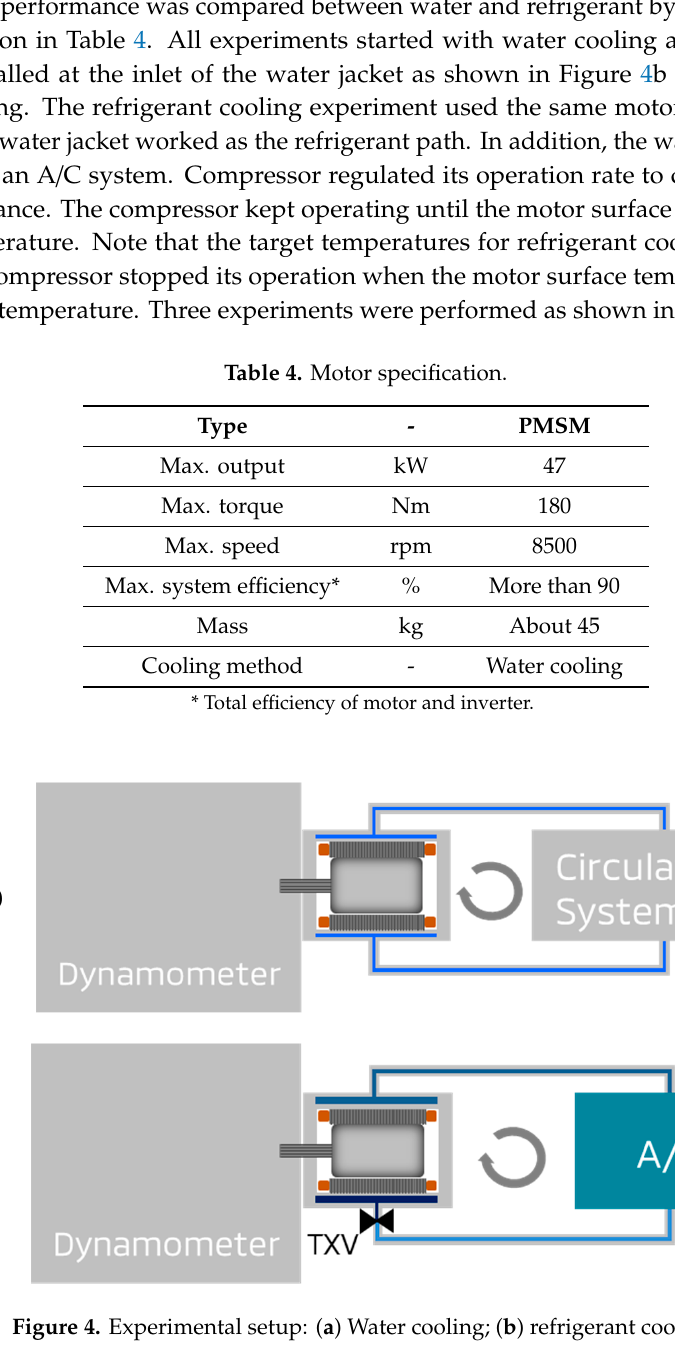
Figure 4. Experimental setup: ( a ) Water cooling; ( b ) refrigerant cooling.